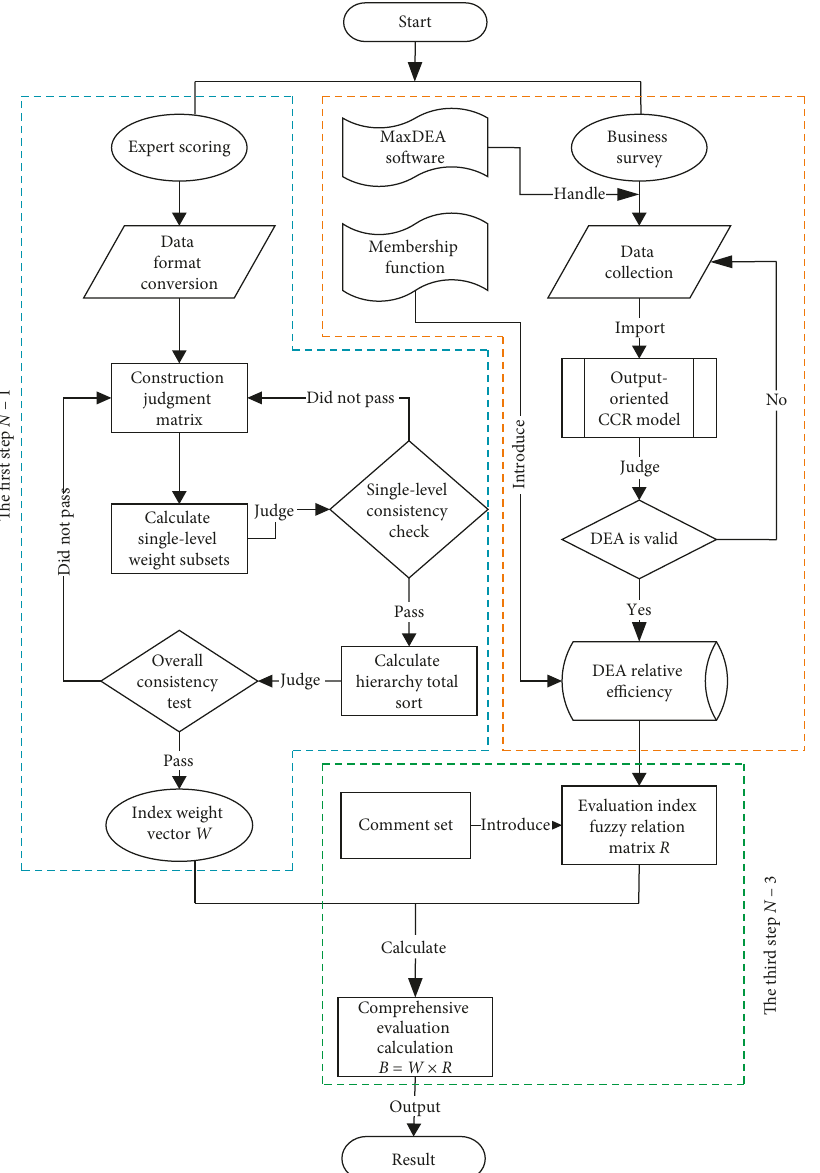
Figure 1: Research